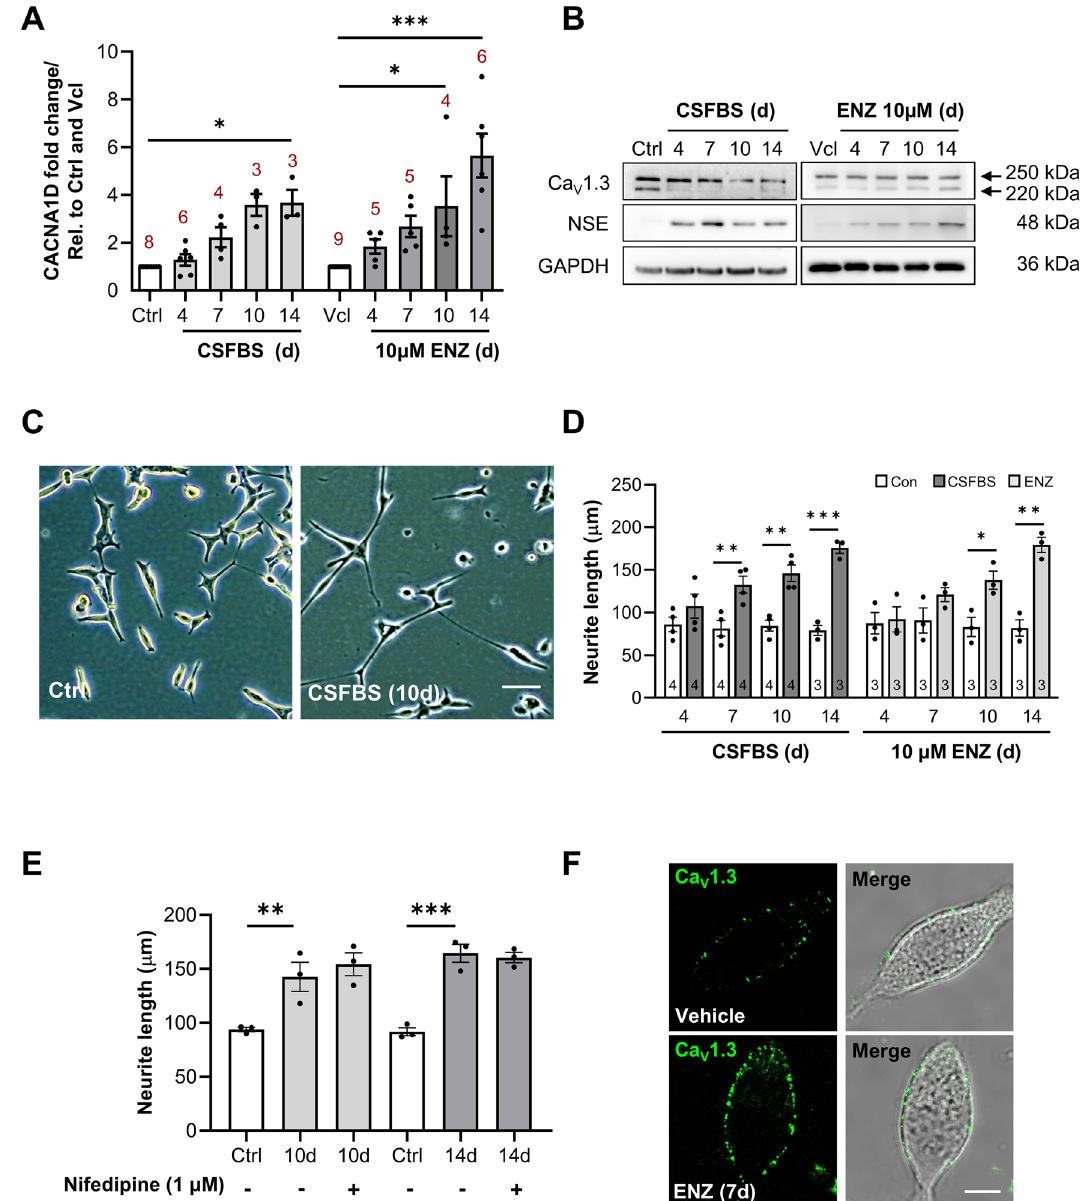
Figure 3. Changes in CACNA1D and Ca V 1.3 expression during recapitulation of hormone therapy. ( A ) CACNA1D transcript expression in CSFBS-cultured and ENZ-treated LNCaP. Transcription expression was normalised to control/vehicle CACNA1D expression and RPLPO housekeeping gene (N indicated above the bars, ‘d’ denotes days). Data was analysed with Kruskal–Wallis test (Dunn’s multiple comparison), p < 0.05 (*) or p < 0.001 (***). ( B ) Western blotting micrographs showing Ca V 1.3 and NSE expression during CSFBS-culturing and ENZ treatment (4–14 days, N = 3). GAPDH was used as a loading control. Uncropped original blots are displayed in Supplementary Figs. S5 and S6. ( C ) Representative light micrographs showing neurite-like extensions in CSFBS-cultured LNCaP compared to untreated controls at 10 days. Scale bar (white line) = 100 µm. ( D ) Average neurite length (µm) in time controls and CSFBS-cultured LNCaP, and during ENZ were compared. Data was analysed using unpaired t-tests with Welch’s correction where p < 0.05 (*), p < 0.01 (**), p < 0.001 (***) (N indicated within bars). ( E ) Nifedipine had no effect on neurite length (µm) in 10 day and 14 day CSFBS-cultured LNCaP. Data was analysed using 1-way ANOVA (Šídák’s multiple.comparison test) where p < 0.01 (**) and p < 0.001 (***) (N = 3). ( F ) Ca V 1.3 membrane surface expression was assessed in live-labelled, non-permeabilised cells imaged with confocal microscopy. Visible Ca V 1.3 membrane foci were observed on the plasma membrane of both vehicle and ENZ-treated (7 days) LNCaP cells (N = 3). Scale bar (white line) = 10